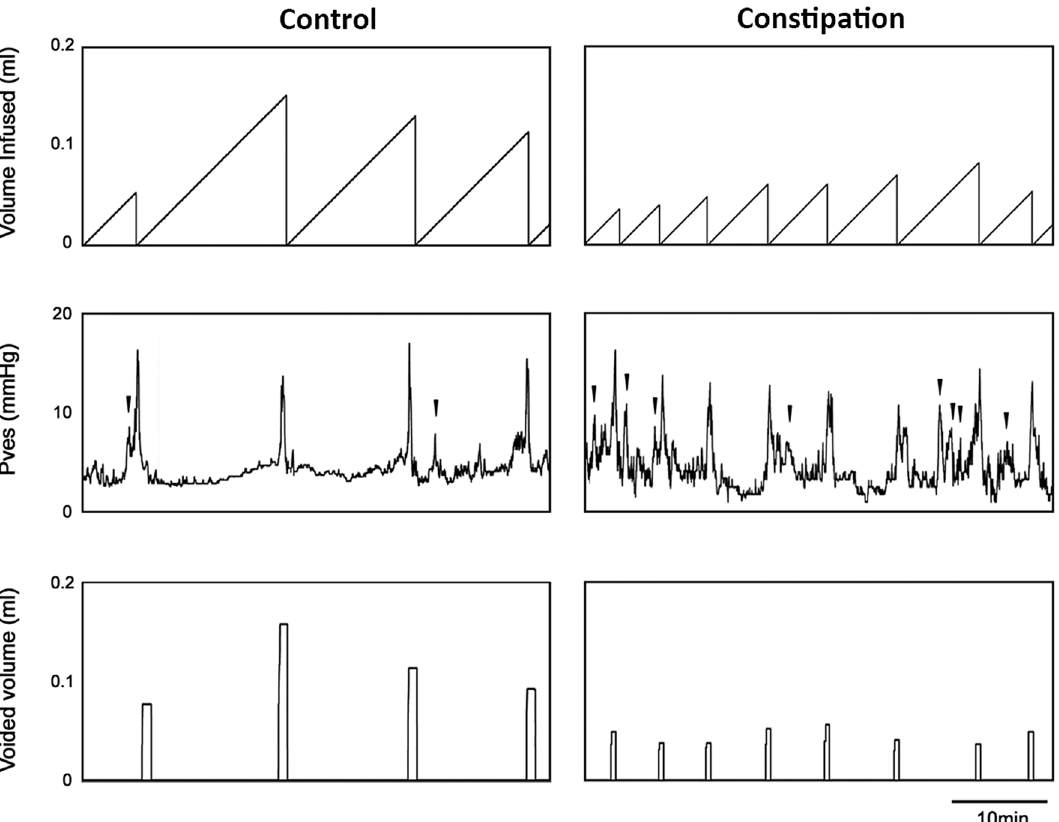
Figure 3. Functional bladder analyses in cystometry. Representative cystometrogram trace from unanesthetized, unrestrained mice in the control (left) and the constipation group (right) during a continuous intravesical infusion (10 μl/min) of room temperature saline. Volume infused (top), intravesical pressure (Pves, middle) and voided volume (bottom) are shown. Arrowheads indicate examples of non-voiding bladder contractions. Figures were prepared using Cystometry Analysis Software (SOF-552, https ://www.med-assoc iates .com/produ ct/cysto metry -analy sis-data-analy sis-softw are/) and Adobe Photoshop CS6.